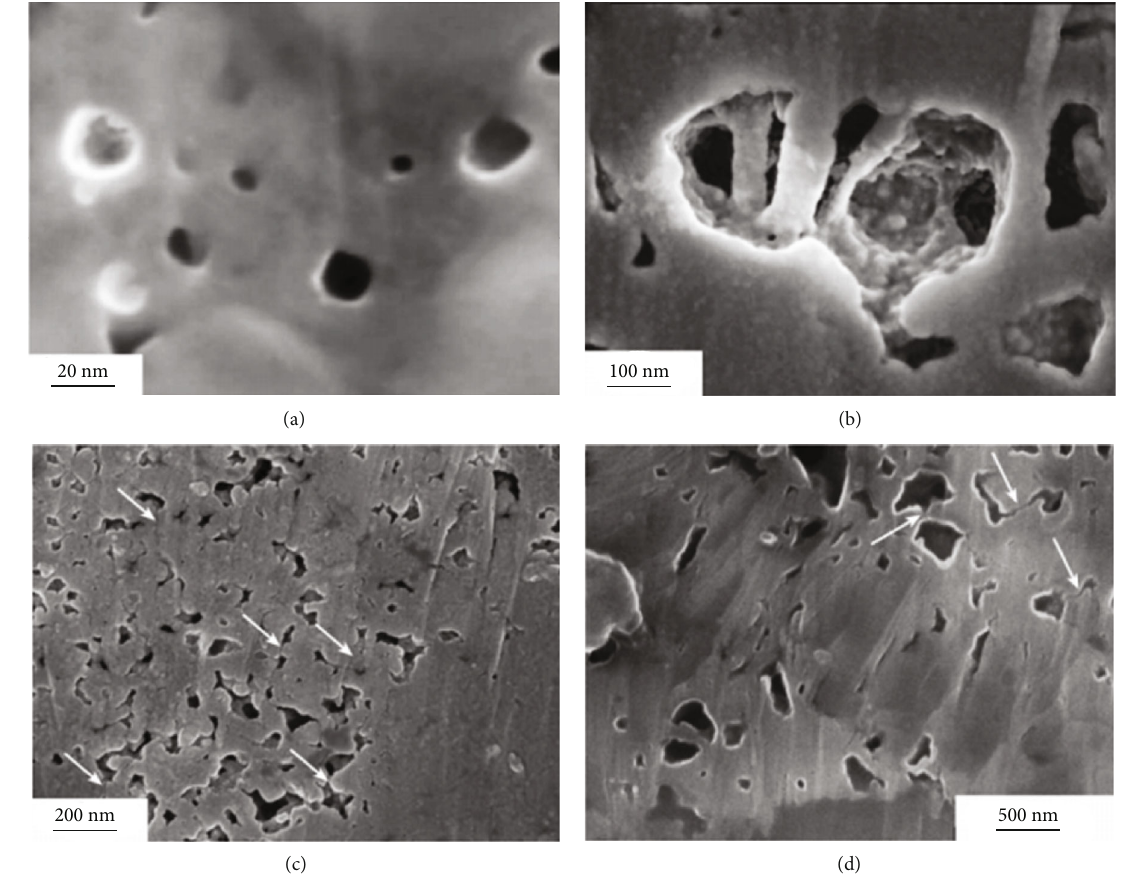
Figure 3: Nanopore in organic matter under a scanning electron microscope